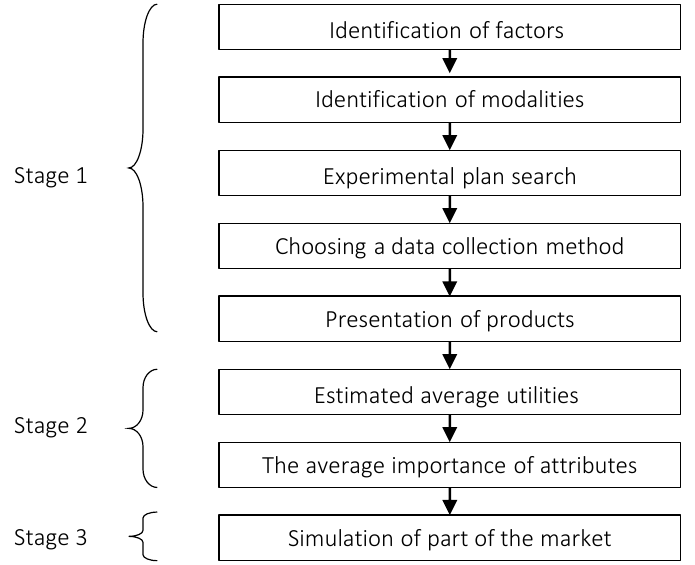
Figure 1. Conjoint analysis